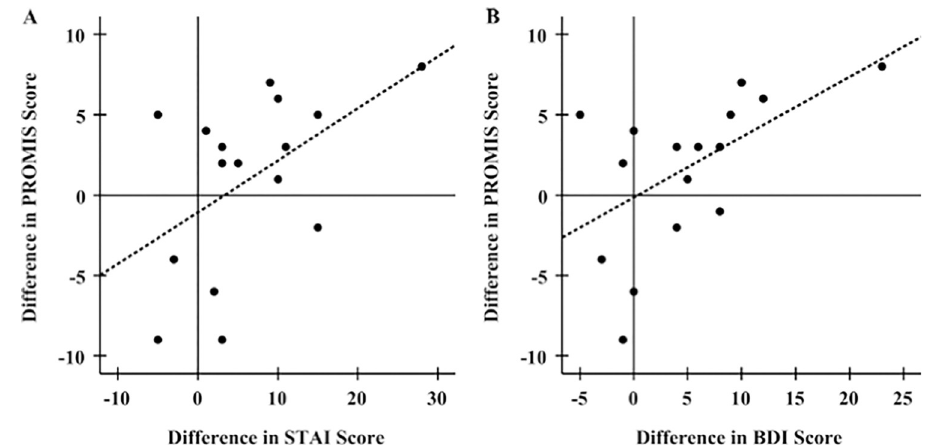
Fig 6. Association of mid-pandemic changes in PROMIS scores relative to pre-pandemic with changes in percentages of REM and deep sleep on free (non-work) days. A) Increasing PROMIS scores during pandemic are associated with decreases in the amount of REM sleep received during the pandemic relative to pre-pandemic (R 2 = 0.269, β = -0.518, p = 0.033). B) Increasing PROMIS scores during pandemic are associated with decreases in the amount of deep sleep received during the pandemic relative to pre-pandemic (R 2 = 0.248, β = -0.498, p = 0.035).